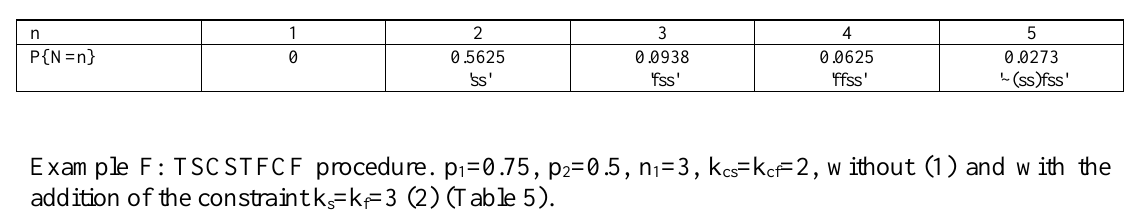
Table 4. P{N=n} for .p 1 =0.75, p 2 =0.5, n 1 =2, k cs =2.